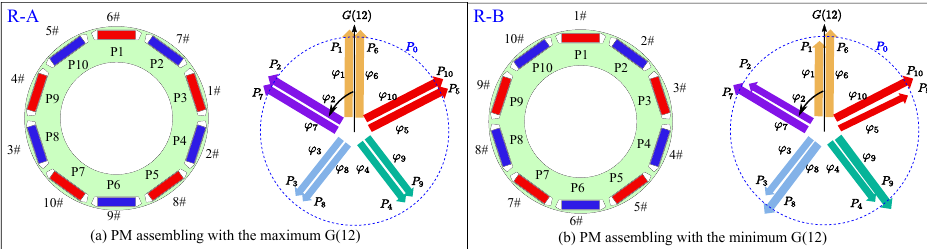
Figure 17. The PM assembling approaches with the maximum and minimum 12th torque harmonics and their corresponding vector diagrams.